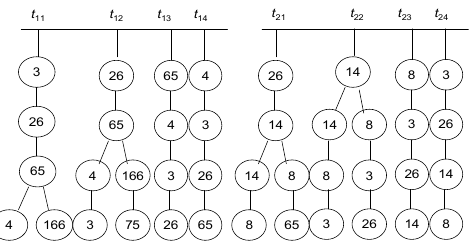
Fig. 1 An example of tree